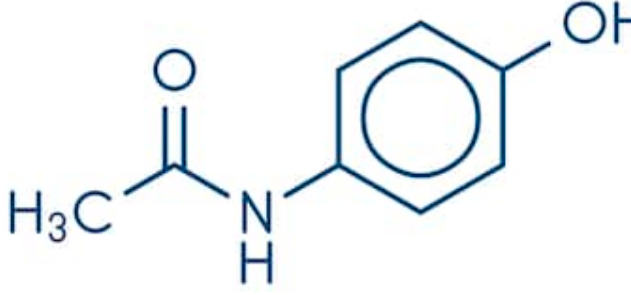
Figure 2. Molecular structure of paracetamol (acetaminophen).